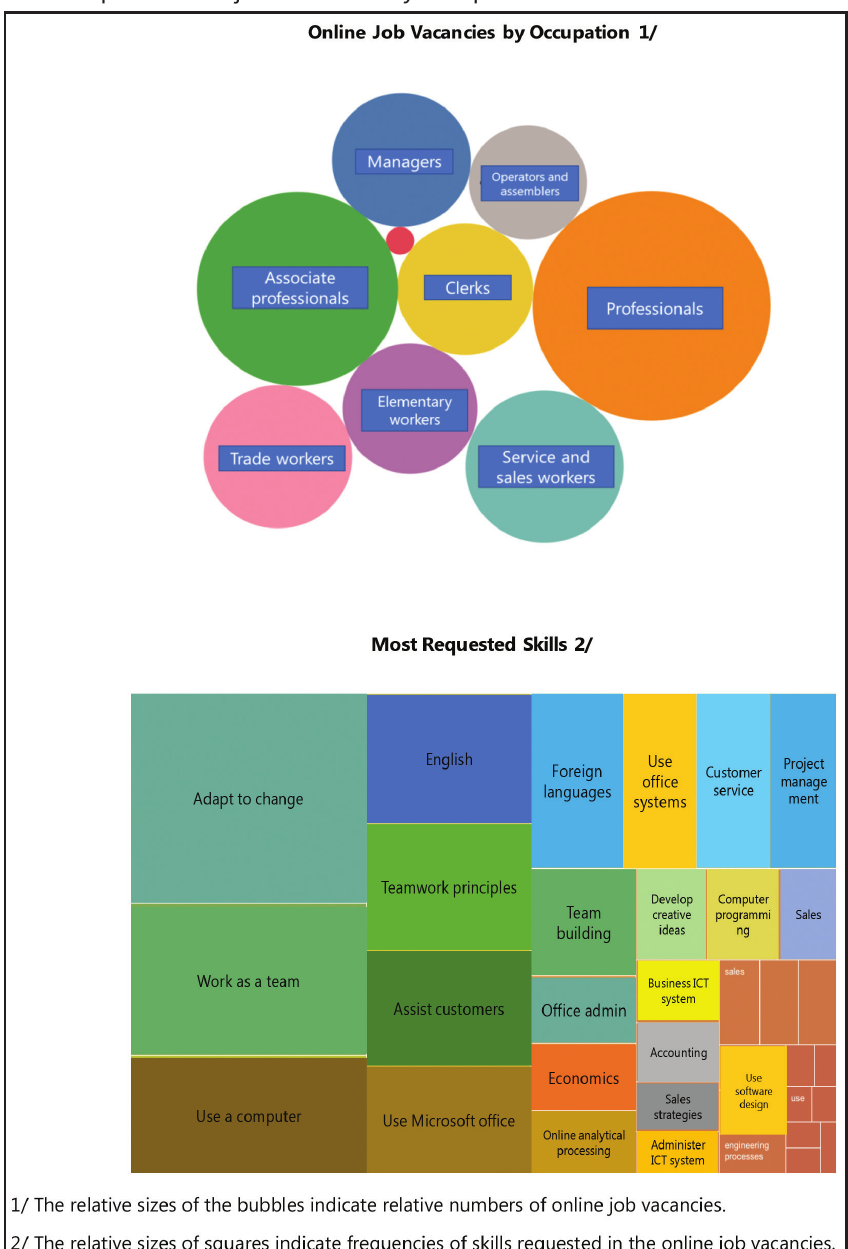
Figure 2 European online job vacancies by occupation and